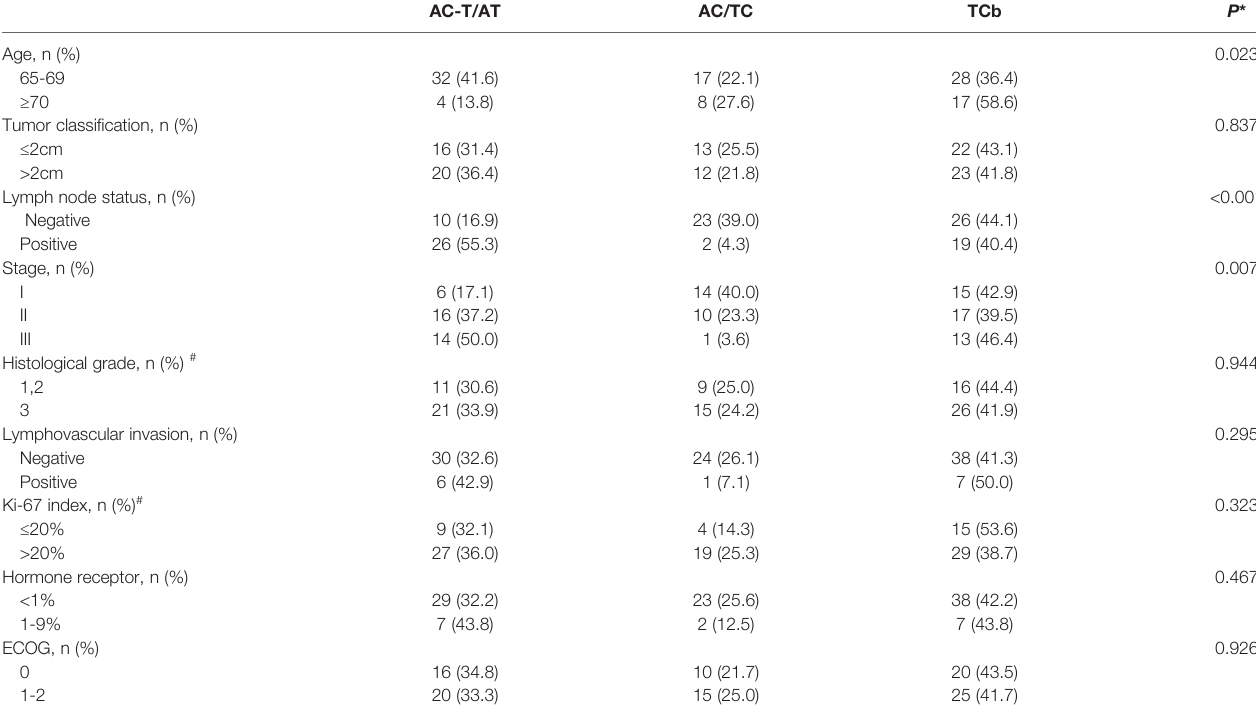
TABLE 2 | Major chemotherapy regimens according to clinical factors.